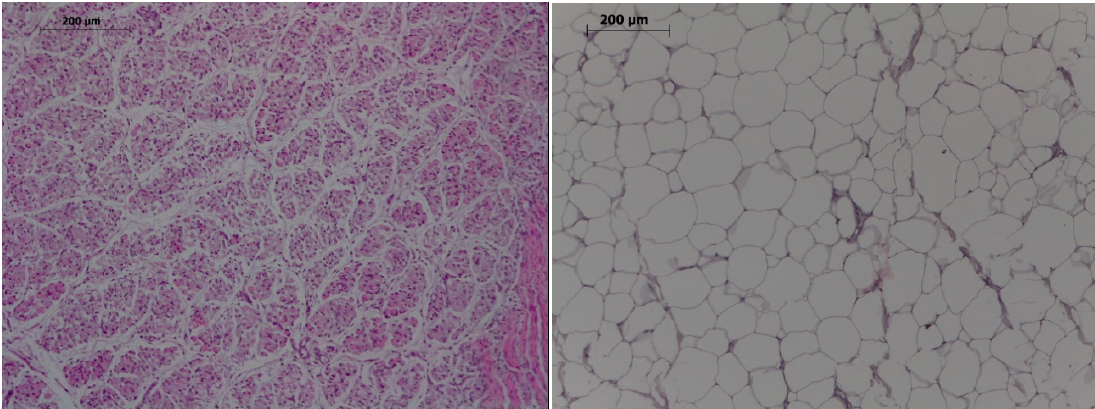
Figure 1. Histological images of muscle (left) and adipocytes (right). Hematoxylin-eosin, 100×, bar 200 µm.